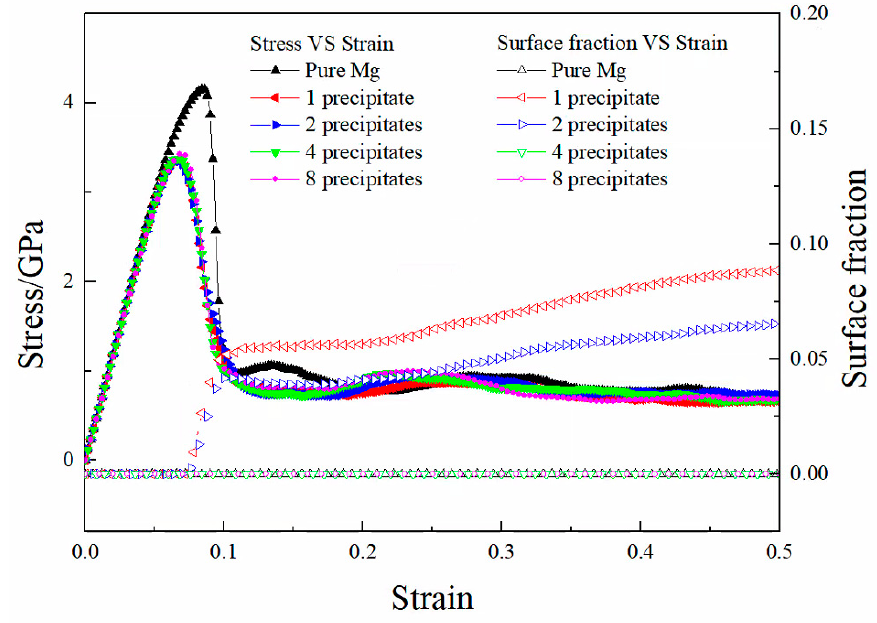
Figure 9. Stress vs. strain and surface fraction vs. strain relationships of multiple systems.